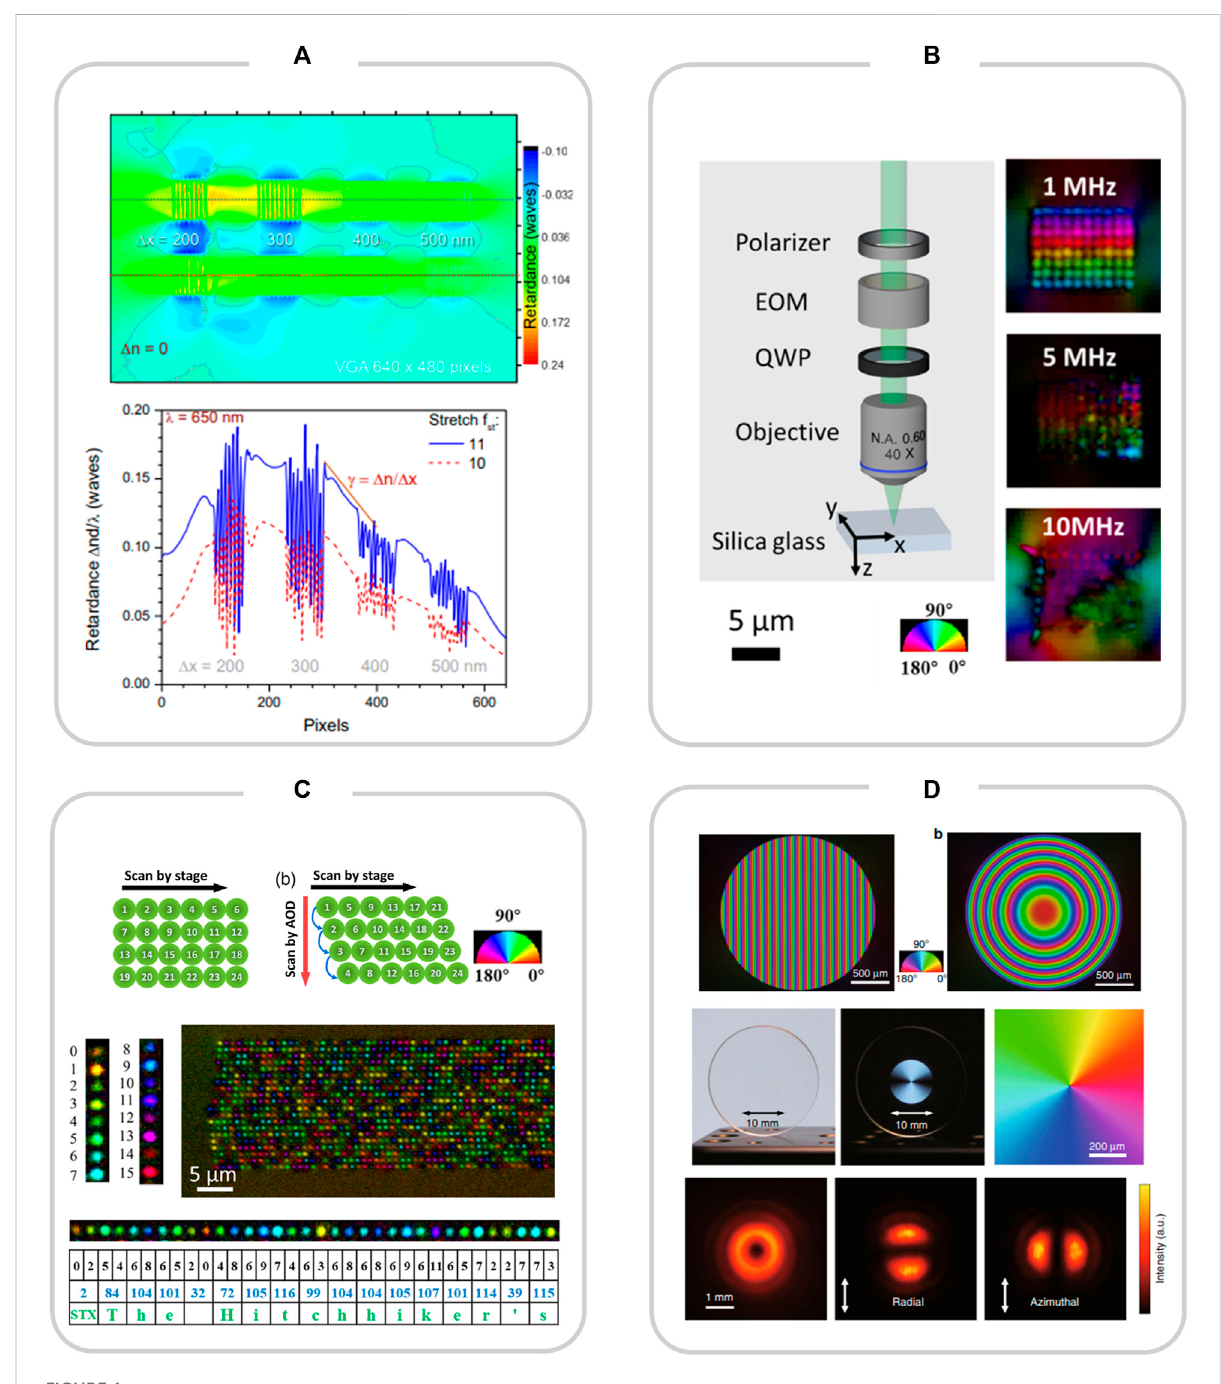
FIGURE 1 (A) Changesinbirefringenceopticalresolutionformedbylarge nanograting inside sapphire; reproduced with permission fromFanetal. (2019). (B) Laser-induced birefringence effect inside silica glass; reproduced with permission from Lei et al. (2021). (C) Femtosecond laser-induced application of silica glass nanograting in optical storage: Optical data storage for 5G data; reproduced with permission from Lei et al. (2021). (D) Femtosecond laser-induced nanograting applications in optics: GP prisms, GP lens and vector beam converters based on low-loss birefringence; reproduced with permission from Sakakura et al.